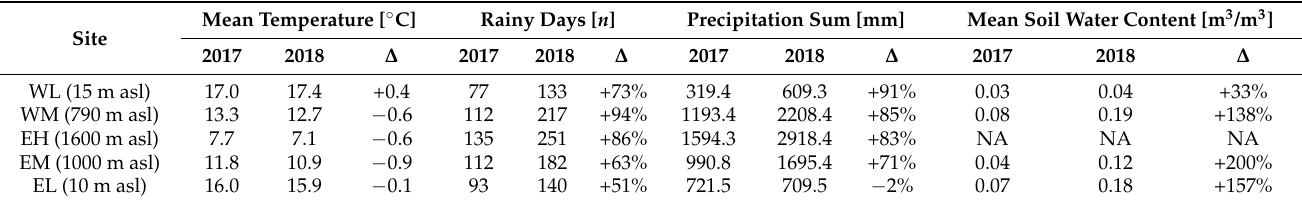
Table 2. Annual sums and averages of climate parameters at study sites. Rainy days refer to days with > 0 mm precipita- tion.